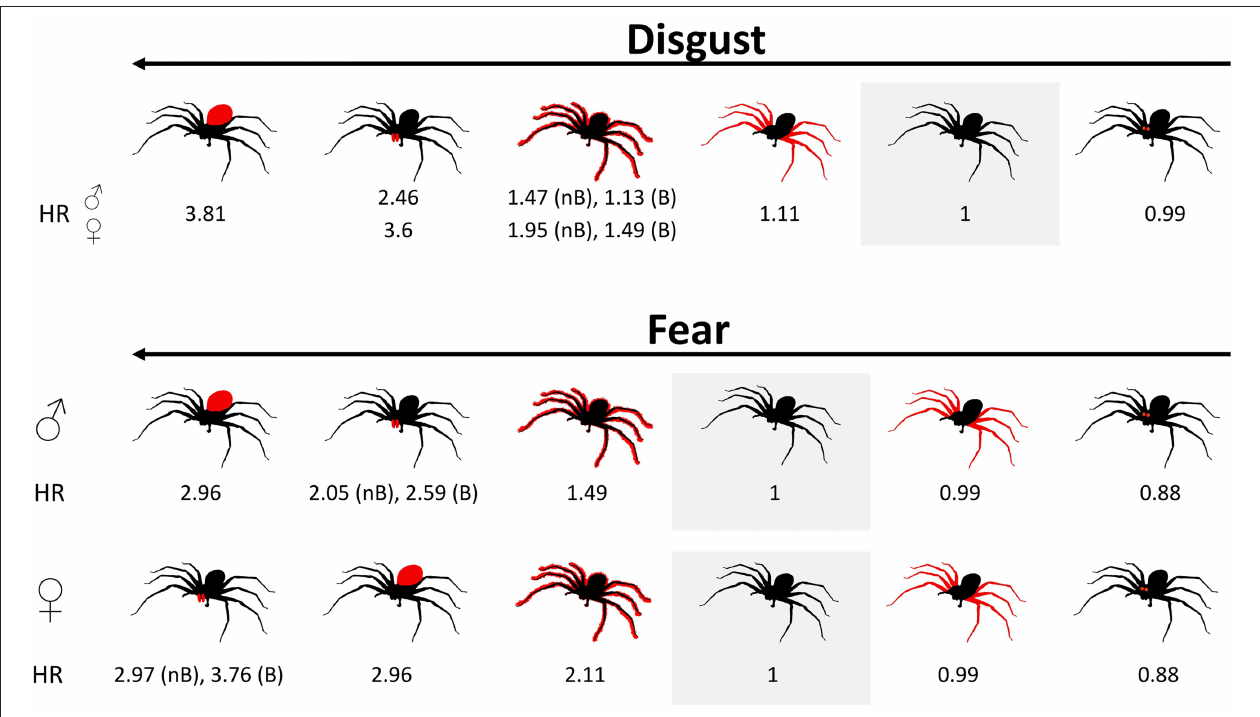
FIGURE 7 | Reliability of spider body traits for disgust and fear perception. HR, hazard ratio; B, biologists; nB, non-biologists; gray square, control.